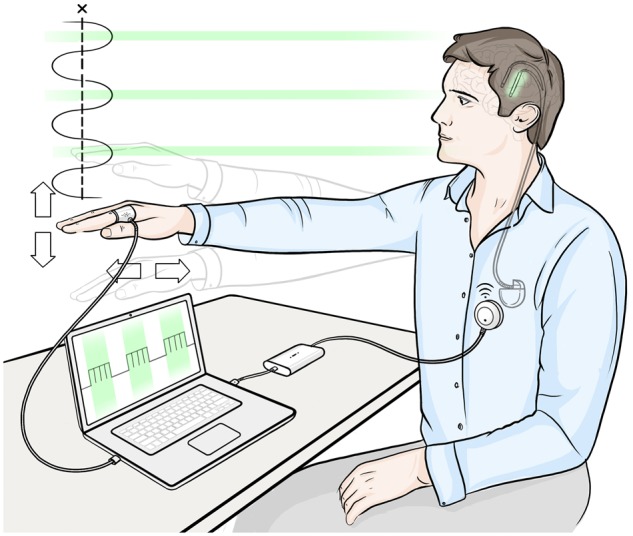
Phase-specific stimulation. The neurostimulator is controlled by patient’s tremor, sensed using the accelerometer attached to the tremulous hand. The green segments indicate when a burst of stimulation is applied to patient’s ventrolateral thalamus. The exact timing of stimulation onset is locked to a particular tremor phase, and the interburst frequency is equivalent to the patient’s tremor frequency.